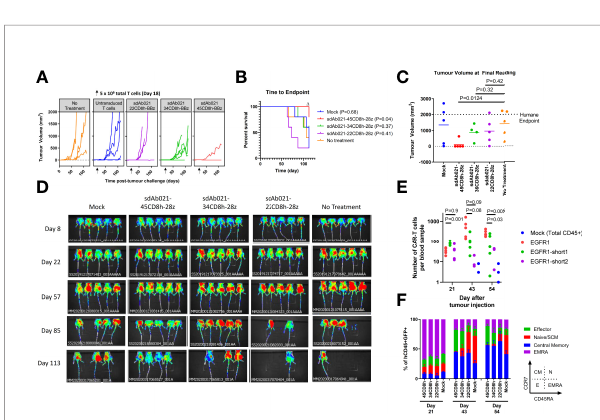
FIGURE 7 | Hinge truncated EGFR sdCAR-T cells show progressively diminished response to human lung cancer xenografts in vivo . NOD/SCID/ IL2 g -chain-null (NSG) mice were injected subcutaneously with 2×10 6 SKOV3 cells stably expressing mKate2. Mice (N=5 mice/group) were injected with 5×10 6 total T cells (~1x10 6 CAR-T cells) intravenously. (A) Tumor volume was assessed using caliper measurements and (B) time to de fi ned humane endpoint (tumor volume 2000 mm 3 ) was assessed. P values are derived from Mantel-Cox test of survival curves in comparison with untreated mice. D Note that the experiment was ended early due to non-experimental related animal facility shutdown, and thus the fi nal tumor measurement of day 112 is shown in (C) . (D) Fluorescence imaging was performed at varying timepoints after tumor cell injection. (E) Blood was also collected at selected timepoints after tumor challenge to quantify the proportion of human CD45+ cells that were GFP/CAR+. (F) Staining for human CCR7 and CD45RA was used to assess the differentiation status of CAR/GFP+ cells or total T cells for mice treated with mock-transduced CAR-T cells. See inset for gating strategy used to de fi ne effector, naïve/SCM, central memory, or effector memory-RA+ (EMRA) cells.